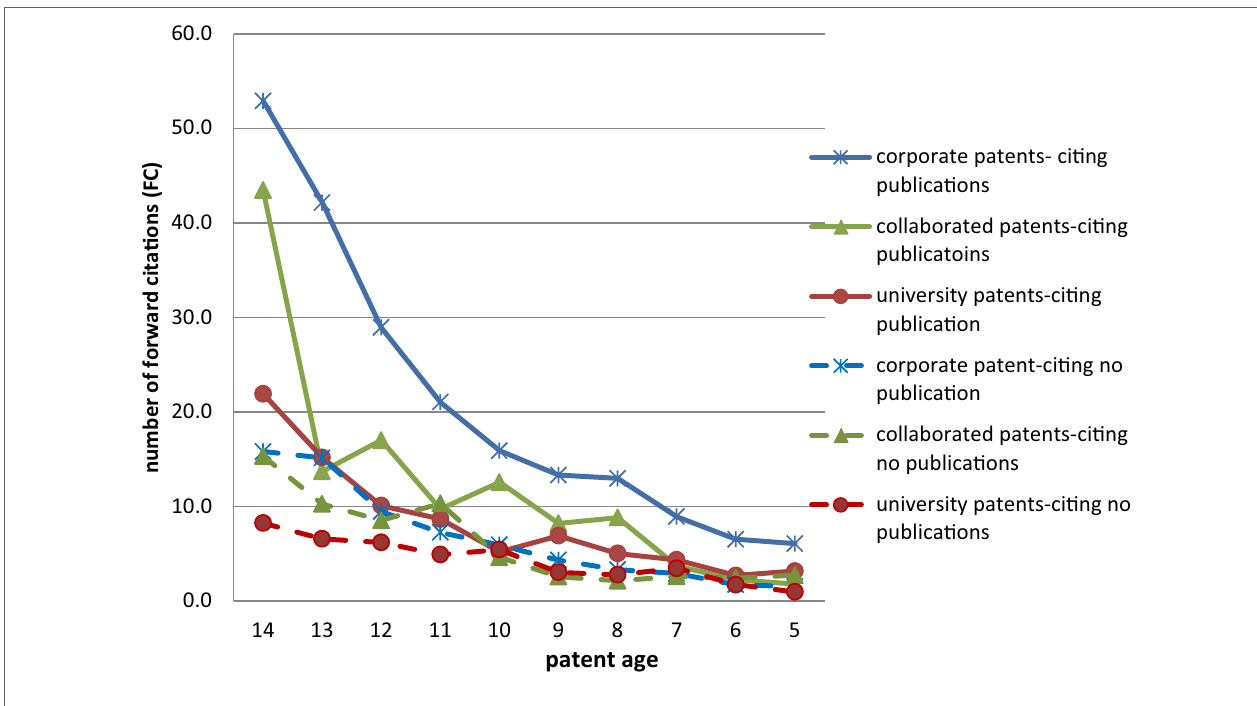
FigUre 4 | The value of patent (forward citations) by patent